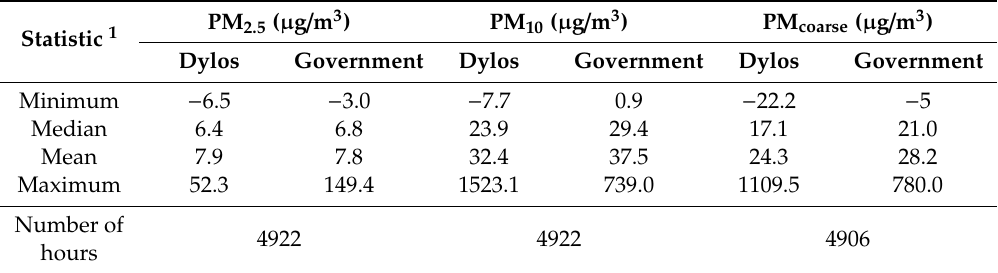
Table 2. Descriptive statistics for hourly PM 2.5 , PM 10 , and PM coarse (di ff erence between PM 10 and PM 2.5 ).